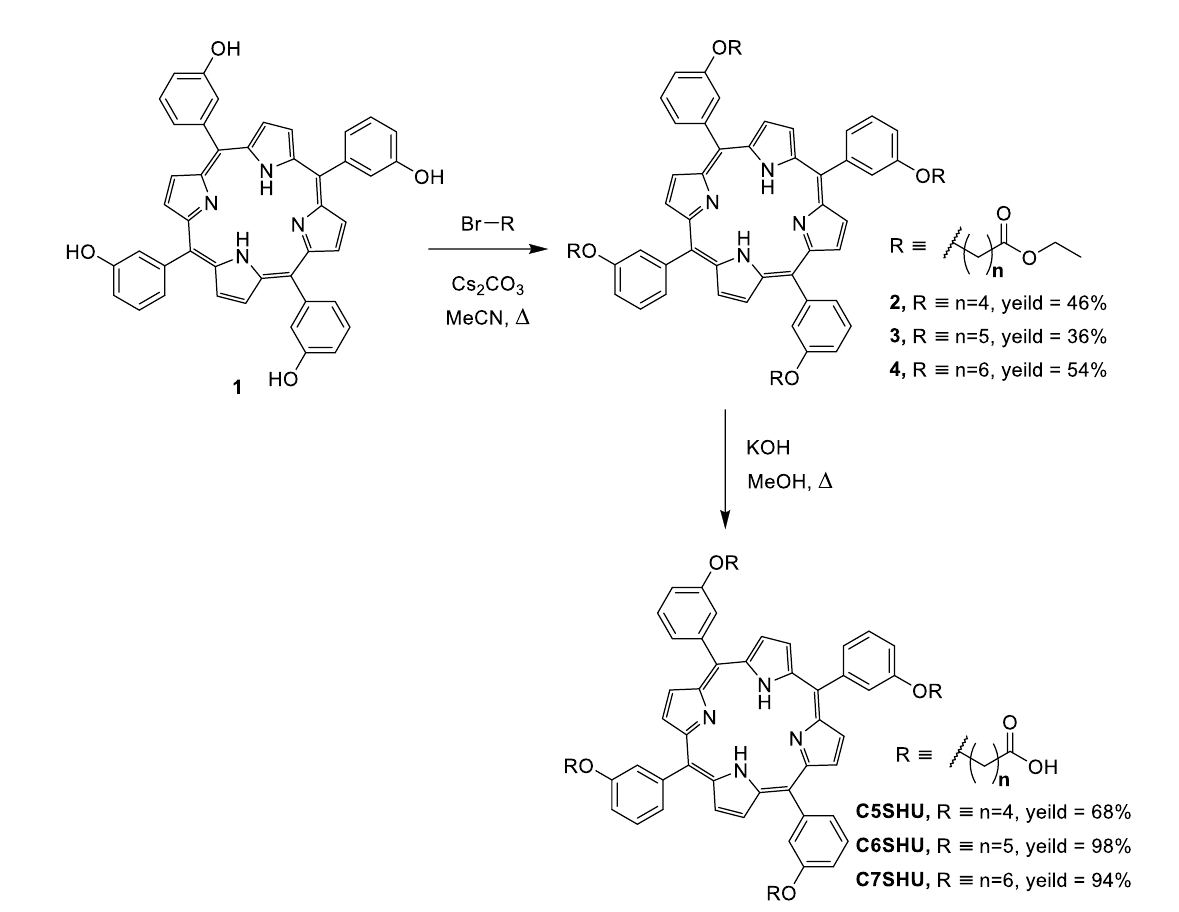
Figure 1. Absorption spectra normalized of porphyrins C5SHU, C6SHU, and C7SHU spectra ( a ), ( b ), and ( c ), respectively, in different solvents made up from the 6 mM NaOH stock solutions. Solid black lines represent the spectra of the porphyrin in DMSO, black dotted line represent the spectra of the porphyrin in water and the black dashed line represents the spectra of the porphyrin in 1 M